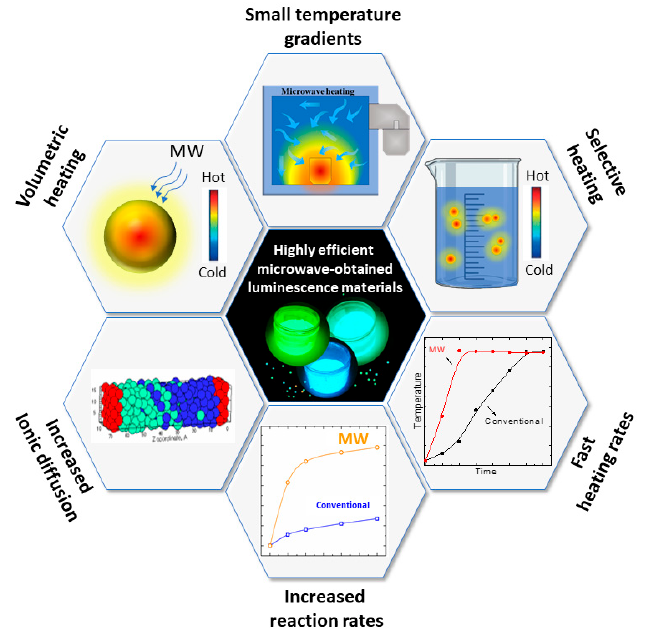
Figure 5. Fundamental microwave-assisted heating properties that are beneficial in preparing luminescent materials.